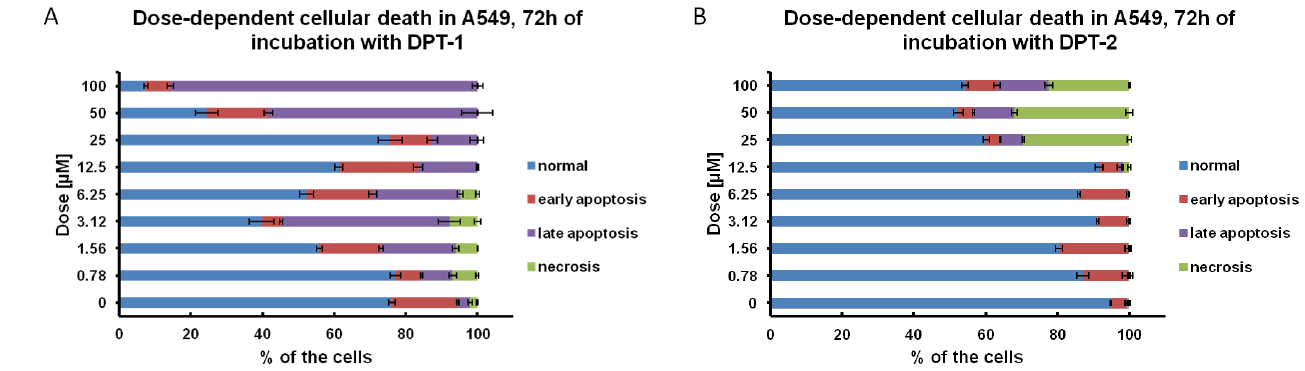
Figure 8. Dose-dependent cellular death in control and ( A ) DPT-1 - and ( B ) DPT-2 -treated A549 cells treated for 72 h, followed by flow cytometry measurements of Annexin-V apoptosis assay and iodium propide (PI) staining (normal cells: Annexin-V − /PI − ; early apoptosis: Annexin-V+/PI − ; late apoptosis: Annexin-V + /PI + ; necrosis: Annexin-V − /PI + ).